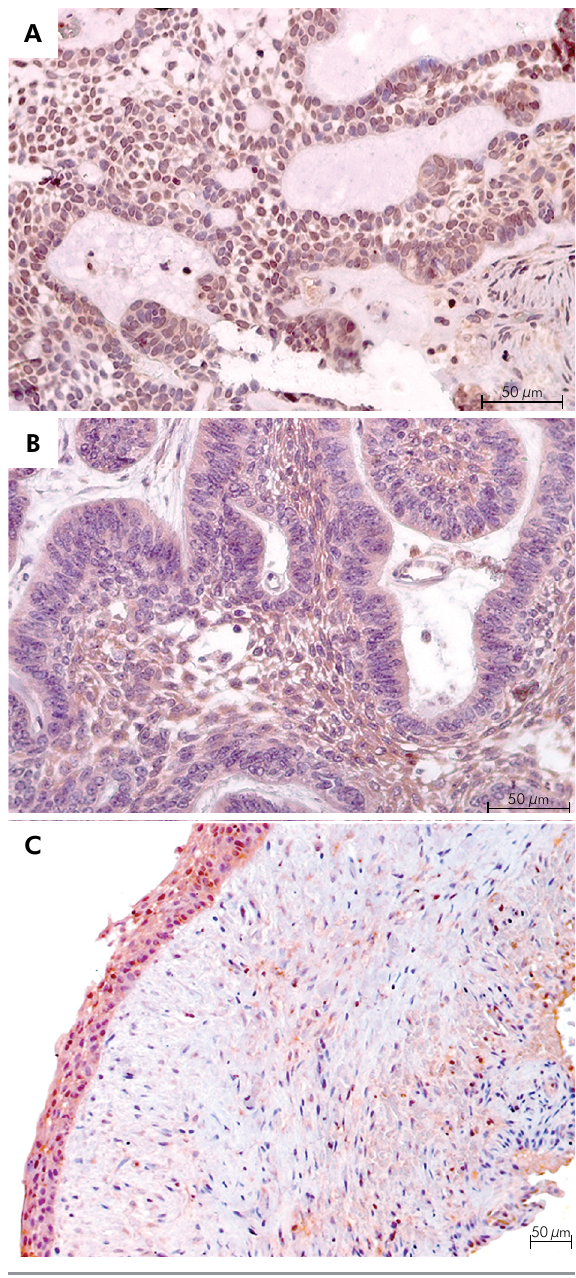
Figure 2. Immunohistochemical expression of P75NTR in multicystic and unicystic ameloblastomas. Nuclear P75NTR expression (A) in the peripheral ameloblast-like columnar cells and (B) in central areas of neoplastic epithelium of a multicystic ameloblastoma. (C) Nuclear P75NTR expression in the neoplastic epithelium of a unicystic ameloblastoma. Magnification indicated in the scale bar.